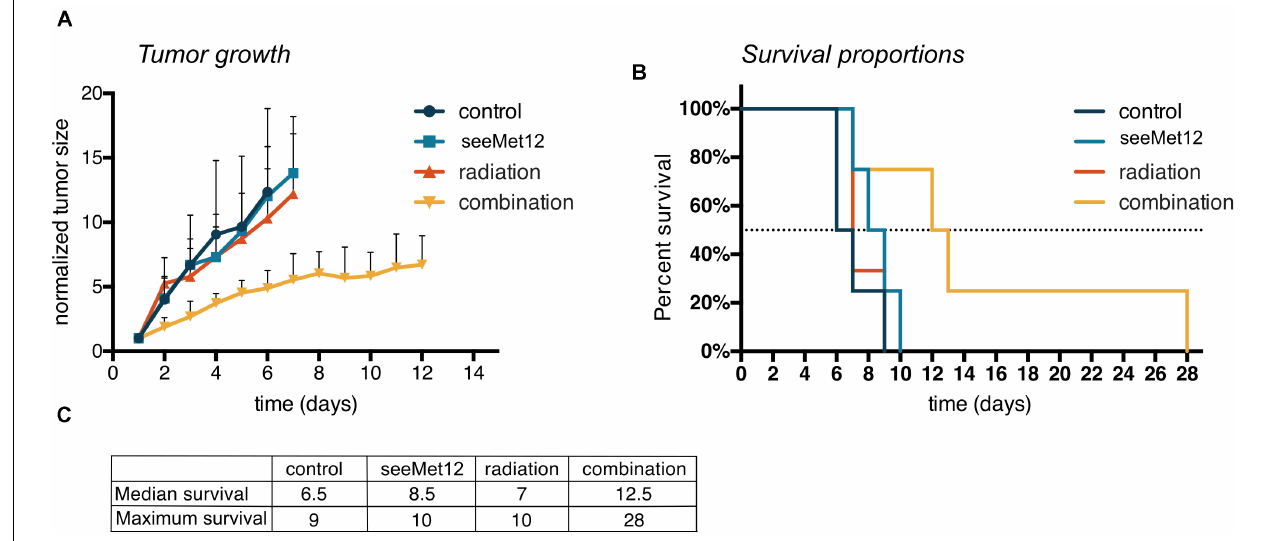
FIGURE 5 | Characterization of seeMet 12 therapy in combination with external radiotherapy in colorectal cancer xenografts. (A) HT-29 tumor growth followed over time, until the first animal in each group was sacrificed. HT-29 xenografted mice received treatment with 5 × seeMet 12 and/or radiotherapy of 3 × 2Gy. Control animals received placebo treatment. n = 4 per group (control, seeMet 12 and combination treatment), n = 3 per group (radiation treatment), Error bars represent SD. (B) Survival proportions of the different treatment groups, n = 3–4 per group. (C) Survival 50% and maximum survival for the different treatment regiments of the mouse xenograft